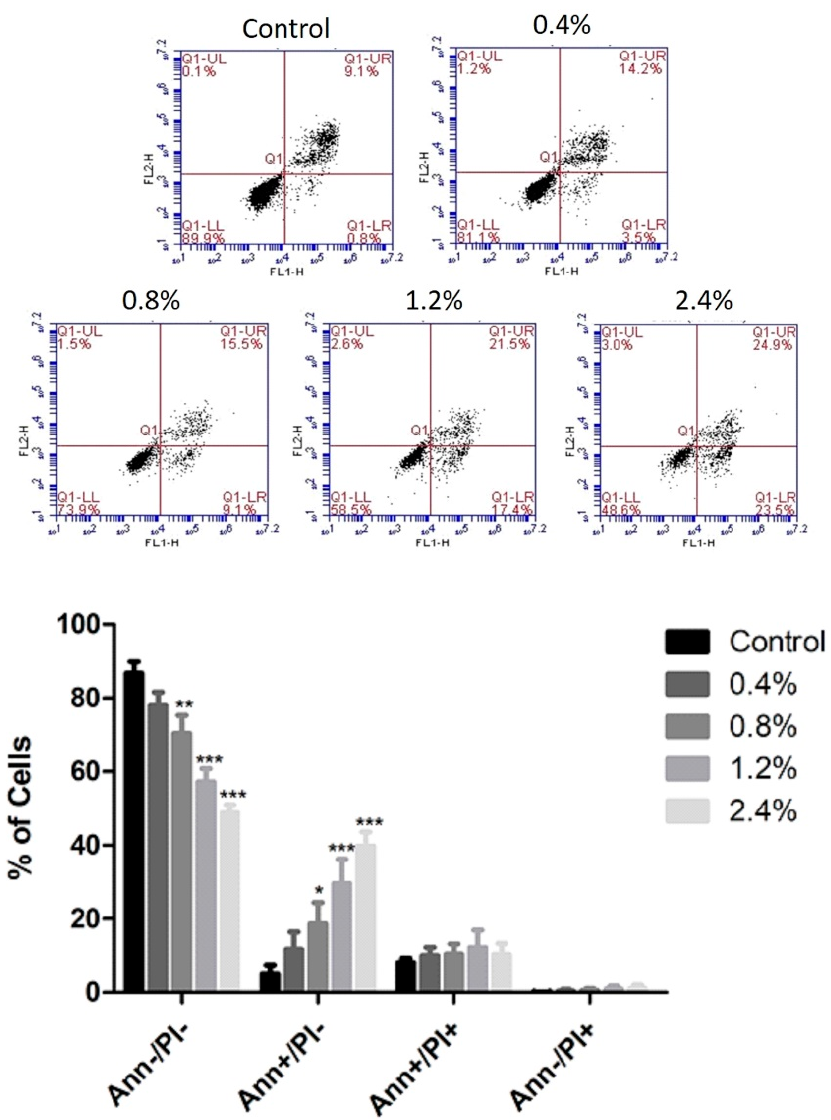
Figure 5. Effect of UD extract on apoptosis after 48 h. U937 cells were treated with different concentrations of UD extract at 0.4, 0.8, 1.2, and 2.4%. The cells were stained with annexin V/PI after 48 h, and then analyzed using flow cytometry. The x-axis represents annexin V and the y-axis represents PI. Lower left quadrant represents Ann − /PI − cells, lower right quadrant represents Ann+/PI − cells, upper left quadrant represents Ann − /PI+ cells, and upper right quadrant represents Ann+/PI+ cells. The histogram represents the means from three independent experiments +/ − SEM. *, **, and *** indicate p < 0.05, p < 0.001, and p < 0.0001, respectively, compared to the control group.